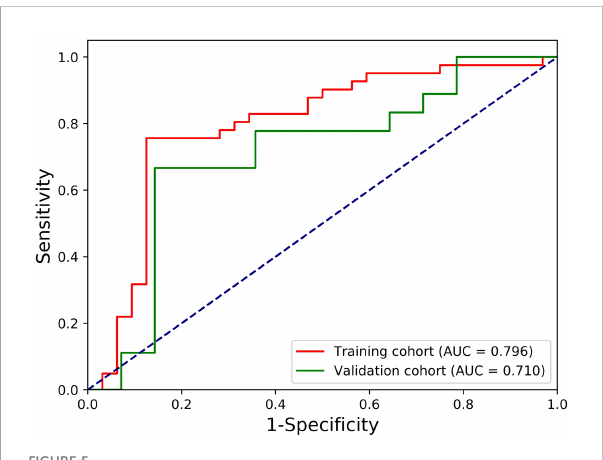
FIGURE 5 ROC curves of the fi nal LR model for predicting the localized nephroblastoma.